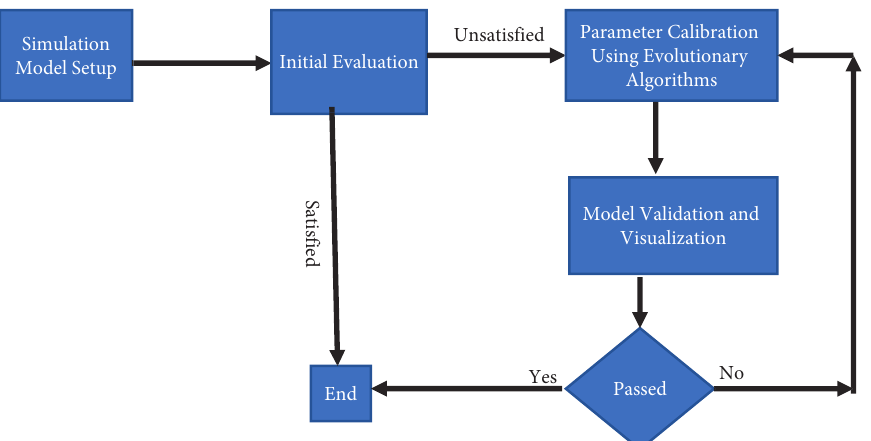
Figure 1: Flowchart for calibration and validation of EGARCH and EGARCH-ANN